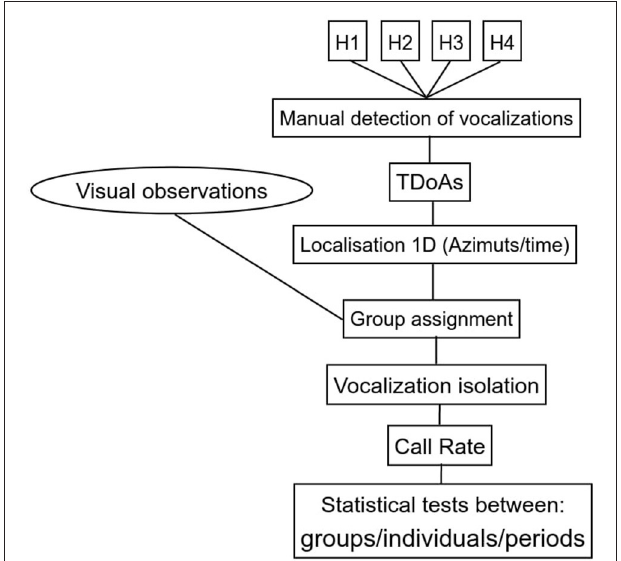
FIGURE 3 | Synopsis of the protocol.